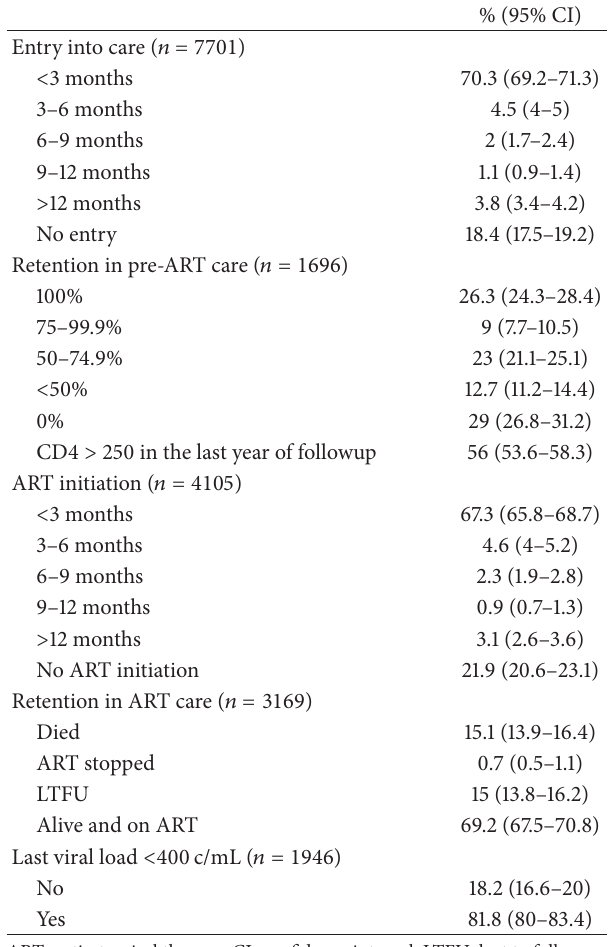
Table 1: Outcomes at each stage of HIV